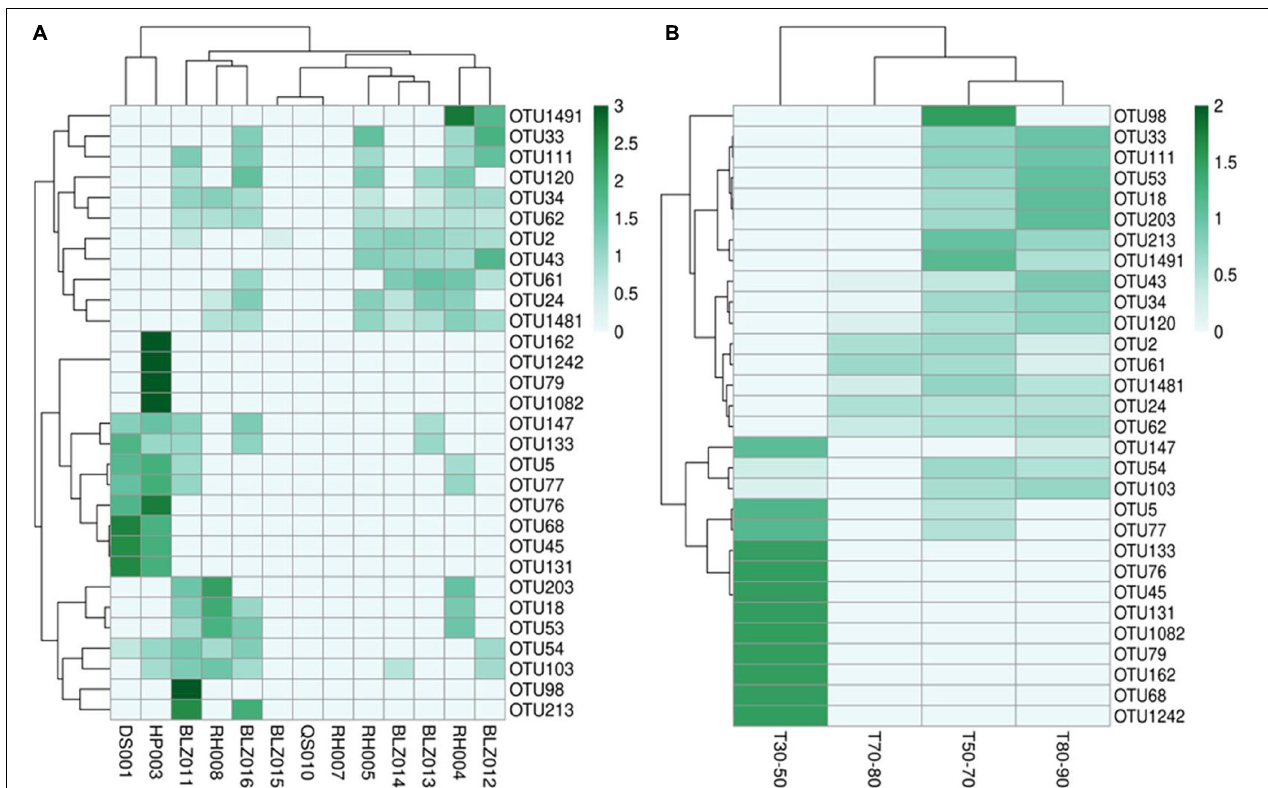
FIGURE 4 | The cyanobacterial OTU abundance clustering heat map. The rows and columns represent the OTU IDs and the sampling sites (A) temperature groups (B) , respectively. The OTU clustering tree is in the left. The value of each square color of the middle heat map corresponds to the relative abundance of each row of OTU. The heat map was generated using the OmicStudio tools (https://www.omicstudio.cn/tool).